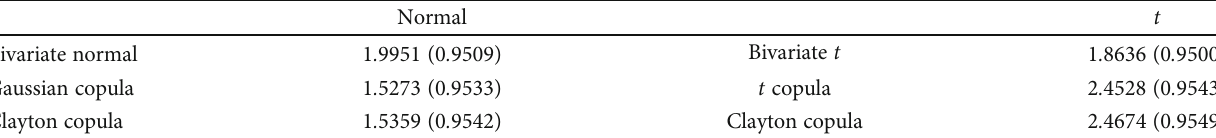
Table 2: The estimative VaR forecast and its coverage probability (in the bracket) of a random loss that depends on another random